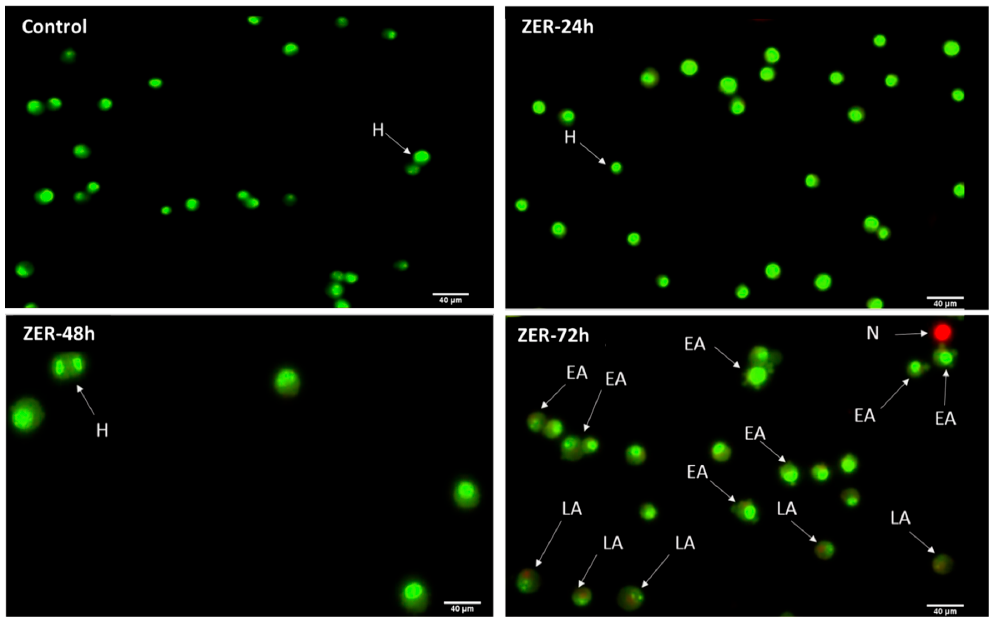
Figure 5. Acridine orange (AO)/propidium iodide (PI) assay for MCF-7 cells treated with the co-administration of zerumbone and TP5-iRGD peptide at three different time points of 24, 48, and 72 h. H: healthy, EA: early apoptosis, LA: late apoptosis, N: necrosis.